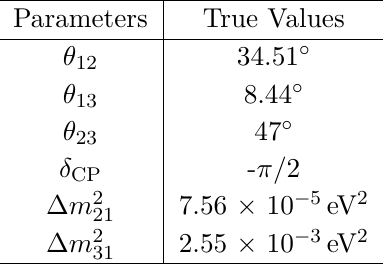
Table 1 . The benchmark values of oscillation parameters used